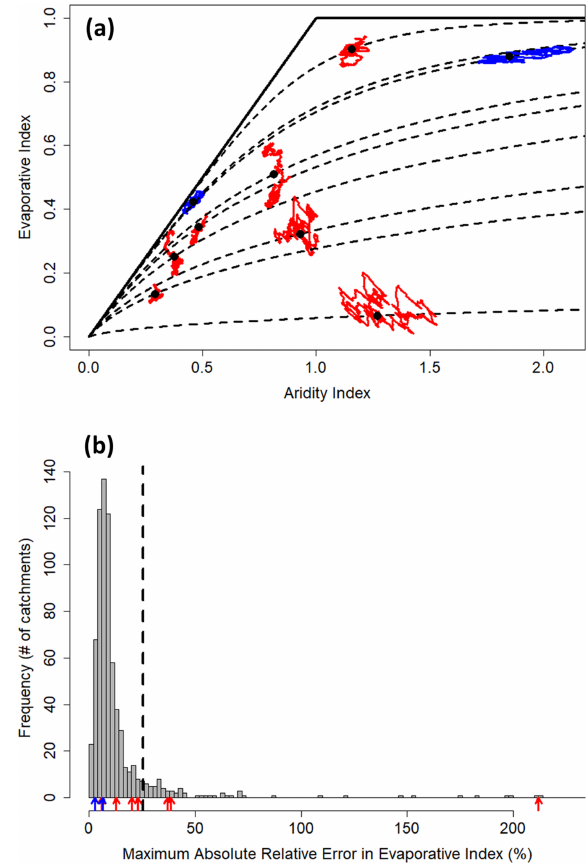
Figure 3. Comparison of actual catchment trajectories with their corresponding expected Budyko curves (Eq. 5) suggested by the catchment trajectory conjecture. (a) Example catchments with sta- tistically distinguishable (red solid curves) and indistinguishable (blue solid curves) actual (10-year average) and expected trajec- tories (black dashed curves). Catchments and p values from the nonparametric sign test, in order of increasing evaporative index: Bull Lake Creek, Wind River Reservation, WY, US, USGS Station 06224000, p ∼ 5 . 84 × 10 − 268 ; River Lune, Killington, Cumbria, UK, NRFA Station 72005, p ∼ 6 . 66 × 10 − 16 ; River Dee, Wood- end, Aberdeenshire, UK, NRFA Station 12001, p ∼ 6 . 66 × 10 − 16 ; Shell Creek, Bighorn National Forest, WY, US, USGS Station 06278300, p ∼ 0; River Ithon, Disserth, Powys, UK, NRFA Sta- tion 55016, p ∼ 4 . 44 × 10 − 16 ; River Fal, Tregony, Cornwall, UK, NRFA Station 48003, p ∼ 0 . 28; Kiamichi River, Big Cedar, OK, US, USGS Station 07335700, p ∼ 8 . 88 × 10 − 16 ; West Clear Creek, Camp Verde, AZ, US, USGS Station 09505800, p ∼ 0 . 061; Little Withlacoochee River, Rerdell, FL, US, USGS Station 02312200, p ∼ 6 . 66 × 10 − 16 . (b) Histogram of the maximum absolute relative error in the evaporative index between the 10-year average actual trajectory realizations and expected trajectories for all 728 reference catchments, truncated to 225%. Values for the nine example catch- ments from panel (a) are indicated with arrows colored in corre- spondence with their statistical distinguishability. The overall mean of the distribution (26%) is given as a vertical black dashed